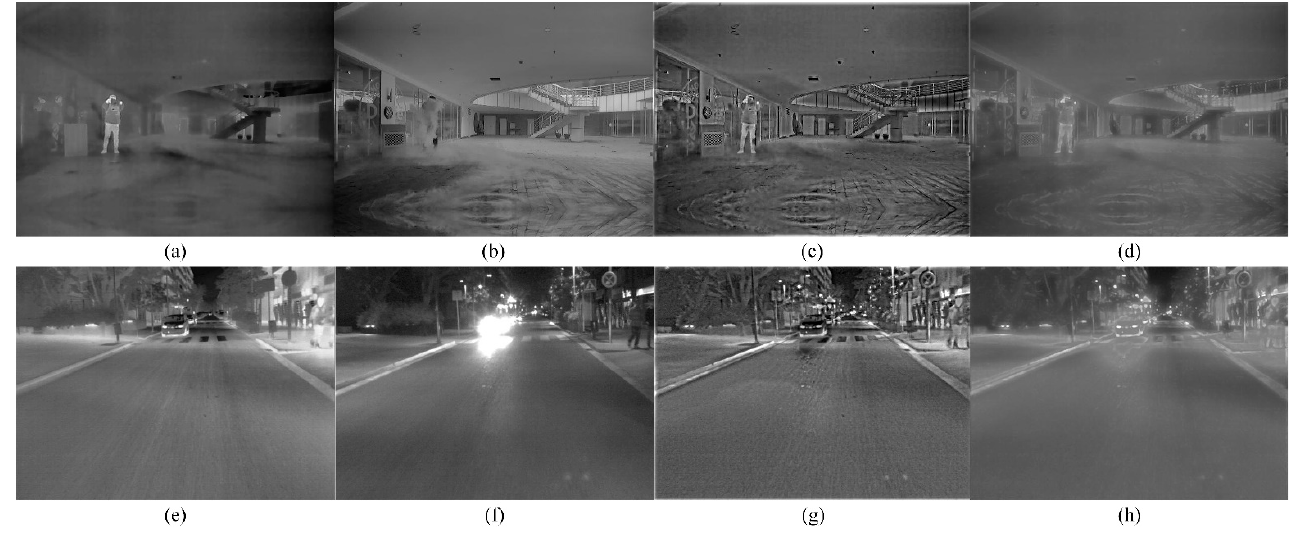
Figure 12. Subjective comparison of the fused image based on FPGA. ( a ) Infrared image with smoke; ( b ) Visible image with smoke; ( c ) Fused image obtained by proposed method in the smoke scene; ( d ) Fused image obtained by Modify-Frei-Chen operator based method in the smoke scene; ( e ) In- frared image with glare; ( f ) Visible image with glare; ( g ) Fused image obtained by proposed method in the glare scene; ( h ) Fused image obtained by Modify-Frei-Chen operator based method in the glare scene.